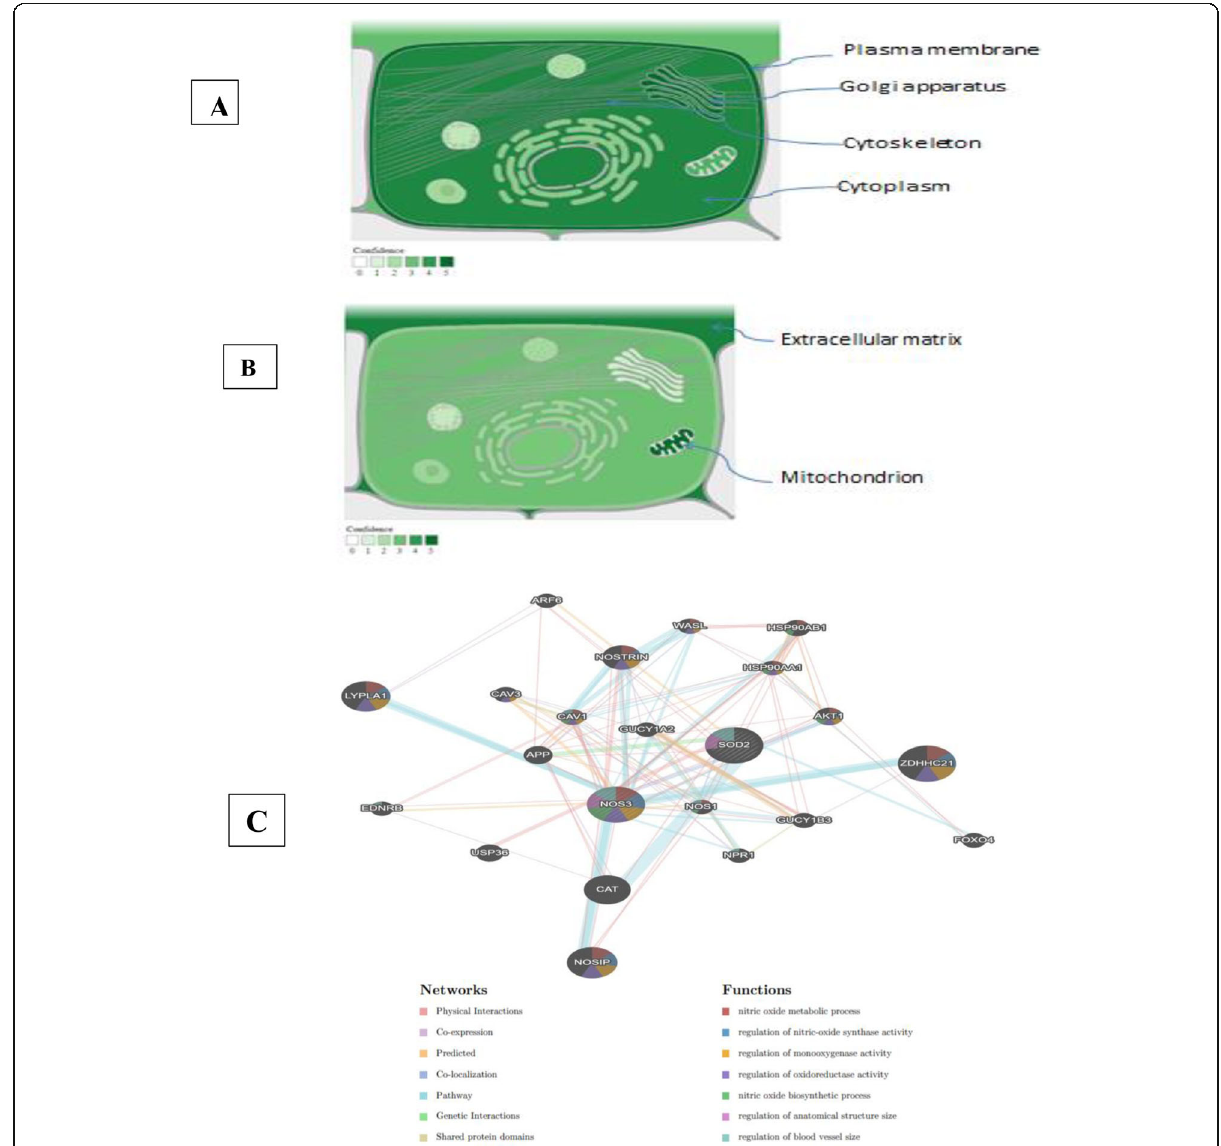
Fig. 4 In silico data analysis. A Subcellular localization of NOS3protein. B Subcellular localization of SOD2 protein. Darker color, according to the provided color key, is indicating more abundance (data source: https://compartments.jensenlab.org/Search). C Gene-gene functional interaction network generated by Gene MANIA. The network nodes have been colored by function (i.e., gene ontology annotation) (data source: